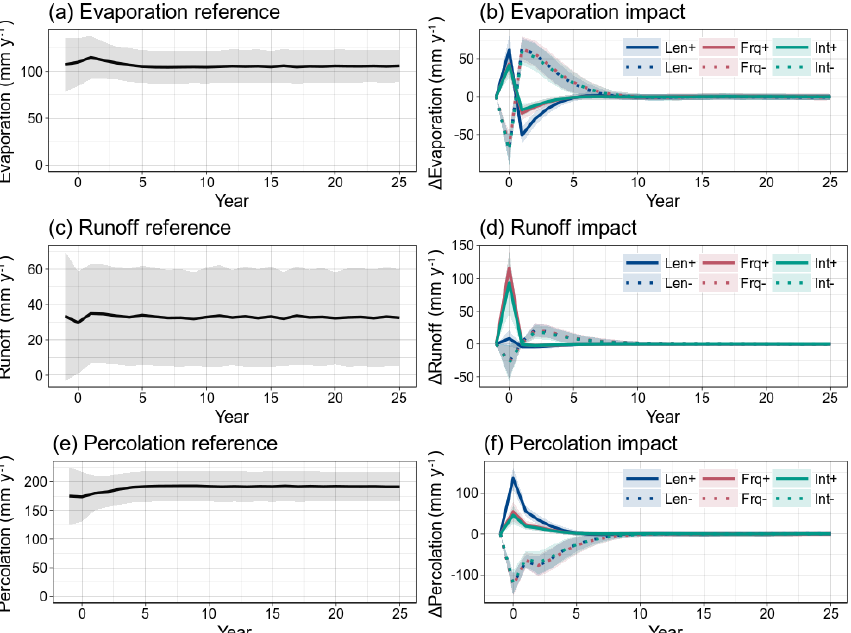
Figure 11. Impact of the different disturbance scenarios on surface water balance. Reference values and impact on (a, b) surface evaporation, (c, d) surface runoff and (e, f) infiltration of water into the soil. Shaded areas indicate variability of the model runs over all ensemble members ( ± 1 σ ). Results shown for the Dahra site simulations.